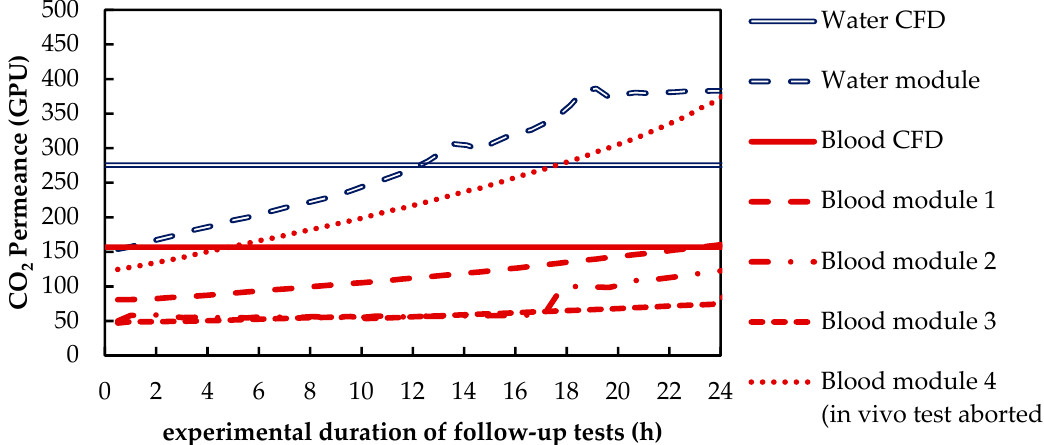
Figure 8. Increase in CO 2 permeance during the follow up gas permeation measurements. Continuous lines: selected values